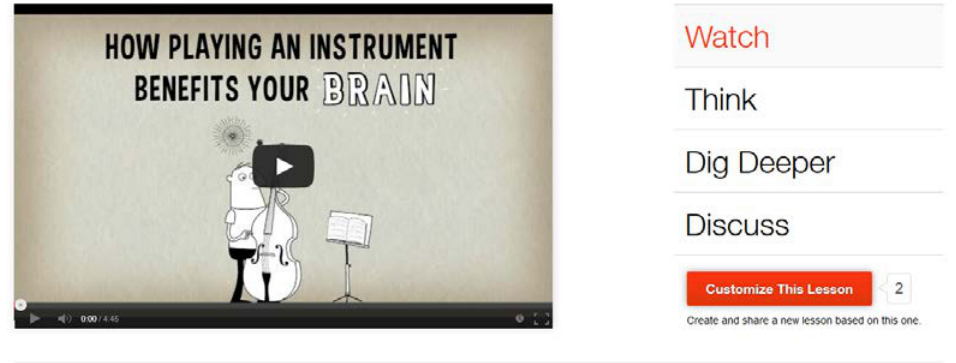
Figure 1 . Example of